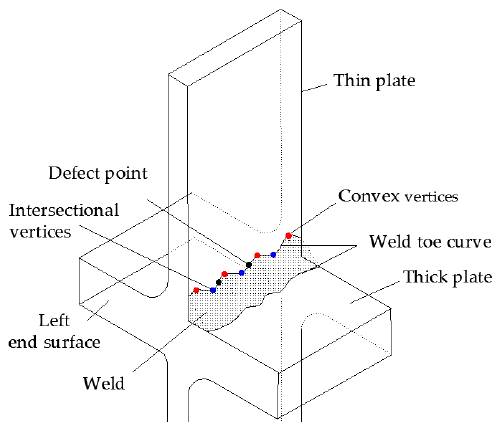
Figure 6. Characteristic points on the weld toe curve. Table 3. Parameters and SCF of characteristic weld sections.